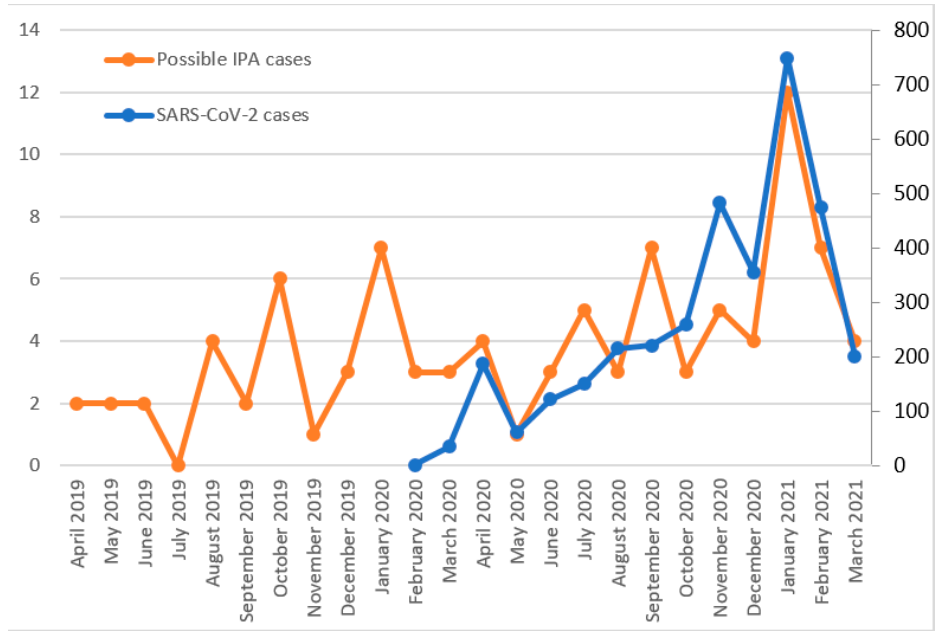
Figure 3. Possible IPA cases (left axis) and SARS-CoV-2 cases (right axis).